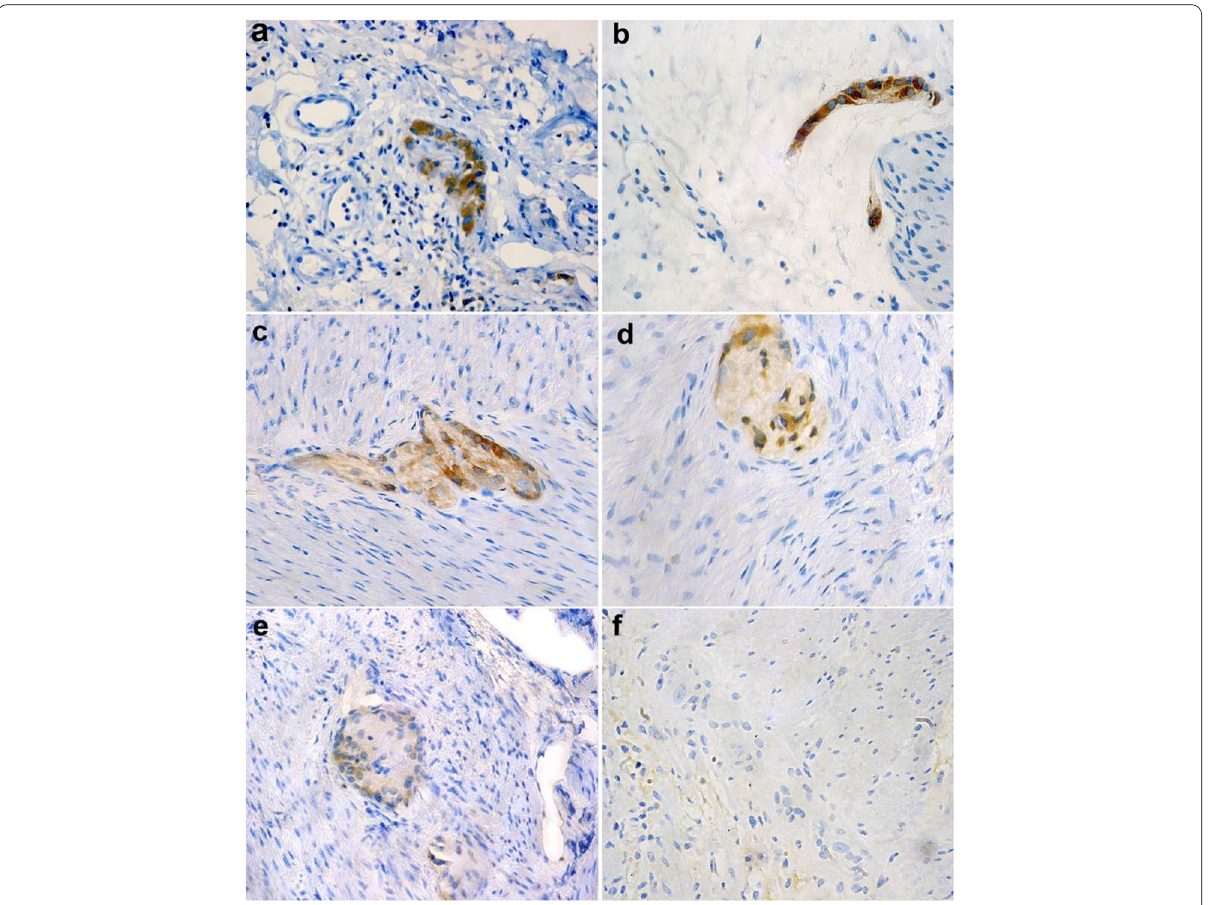
Fig. 4 Immunohistochemical expression of Bcl-2: Strong Bcl-2 positivity of > 6 ganglion cells (IHC score 3 staining of five ganglion cells with negative staining of mature ganglion cells (IHC score 2 for Bcl-2 (IHC score 1 , 400) ( d ). Negative Bcl-2 staining in ganglion cells (IHC score 0, + × showing negative Bcl-2 expression (IHC score 0, 400) ( f ) ×